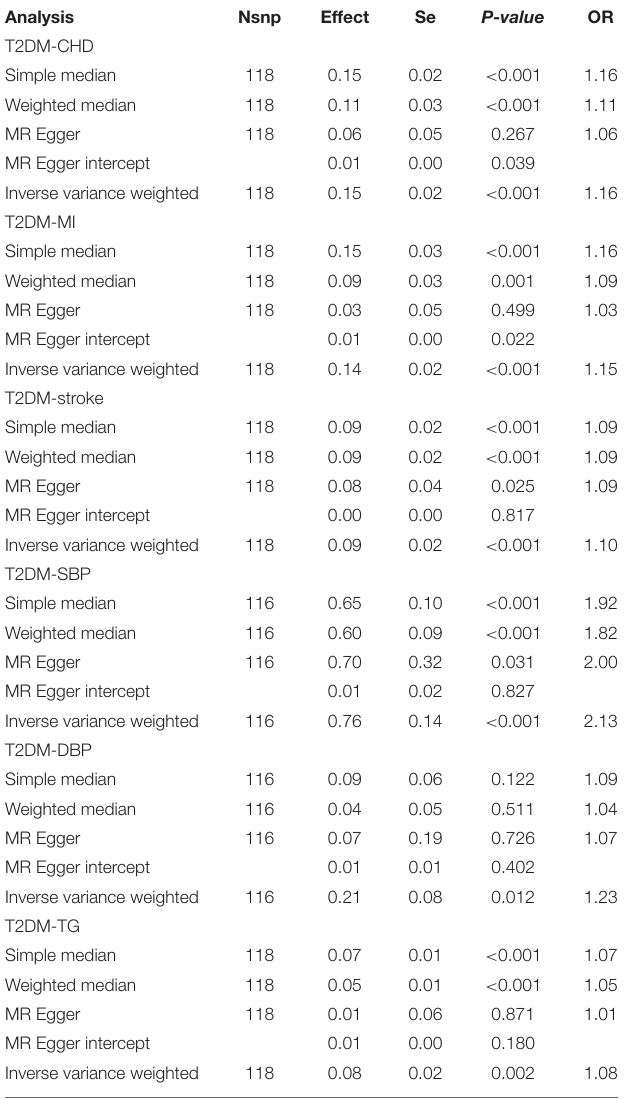
TABLE 1 | MR sensitivity